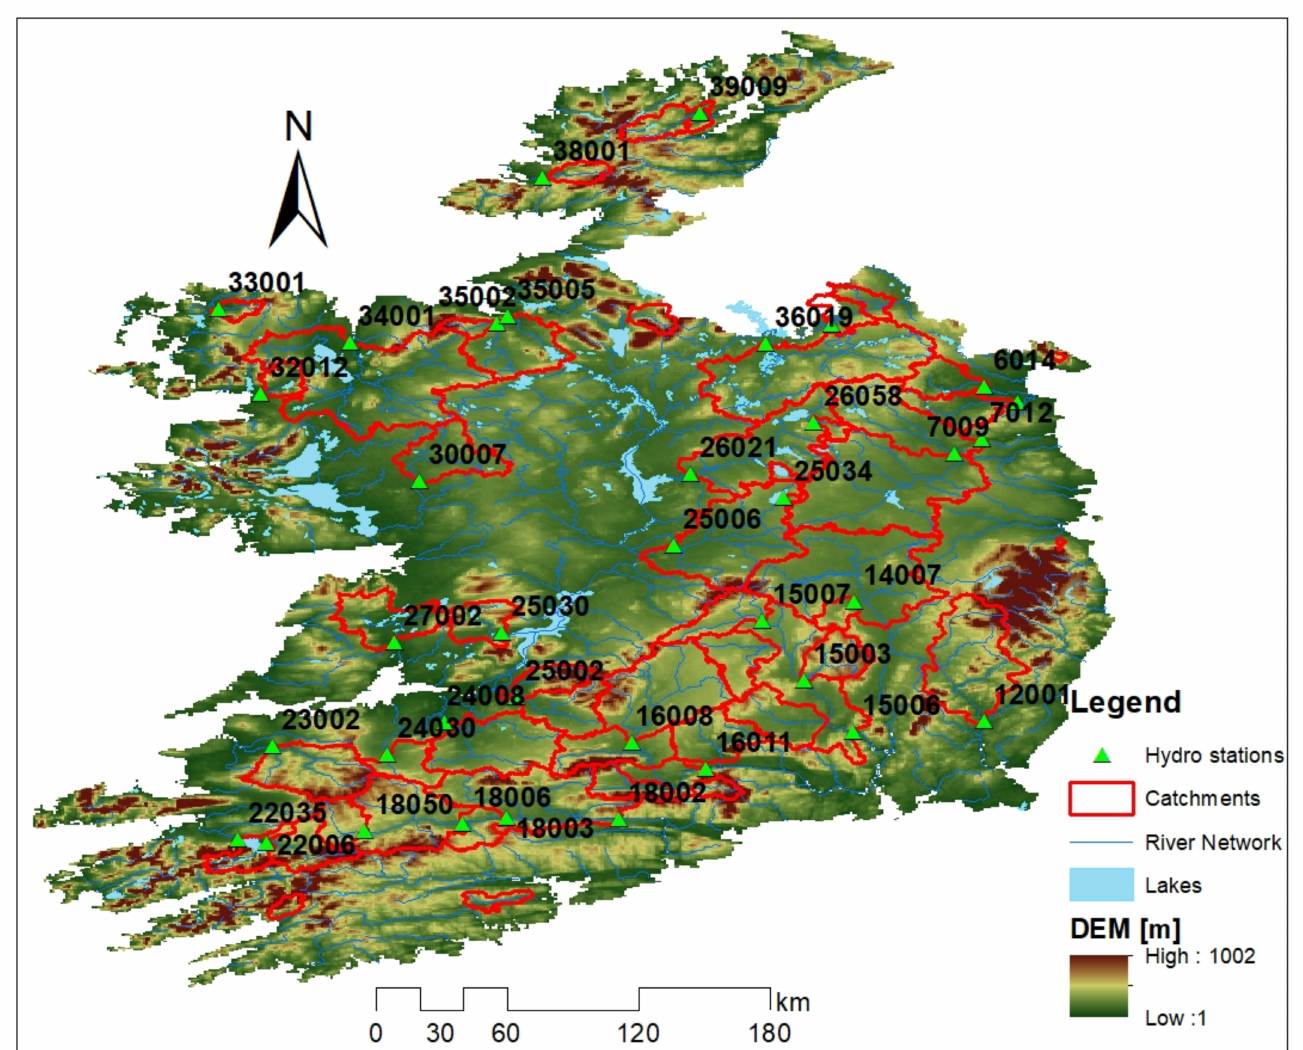
Figure 1. Distribution of the 37 catchments used in the analysis. The red line identifies the catchment boundary, while the green triangle indicates the location of the gauging station. The numbers listed are unique hydrometric codes used to identify gauges and correspond to those given in subsequent